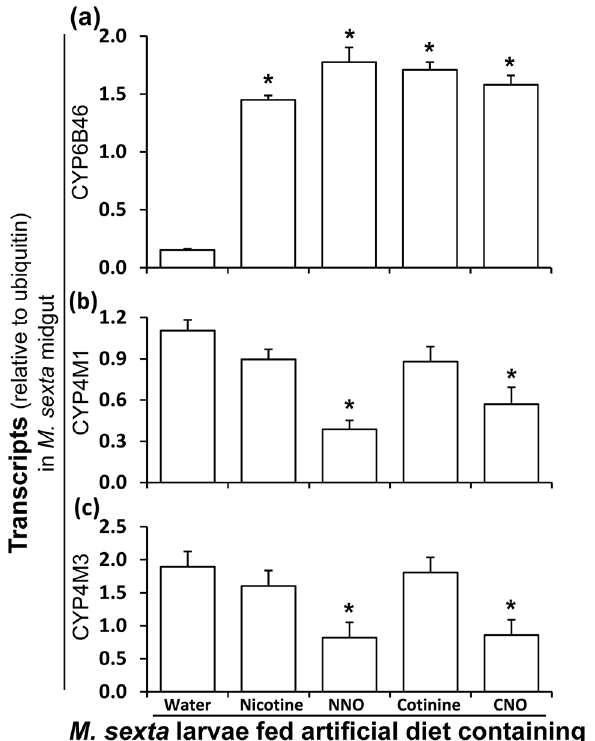
Figure 2. Transcript regulation of M.sexta CYPs in response to ingestion of nicotine and nicotine oxides. ( a ) CYP6B46 [(mean 6 SE) F 4, 19 =94.5, P # 0.05, n=5] ( b ) CYP4M1 [(mean 6 SE) F 4, 20 =9.5, P # 0.05, n=5] and ( c ) CYP4M3 [(mean 6 SE) F 4, 20 =11.1, P # 0.05, n=5] transcript levels (relative to ubiquitin) in midguts of 48 h old first-instar M. sexta larvae fed artificial diet containing water (control) or 0.1% (fresh mass) nicotine, NNO, cotinine or CNO. Asterisks indicate significant differences ( P # 0.05) by one-way ANOVA.